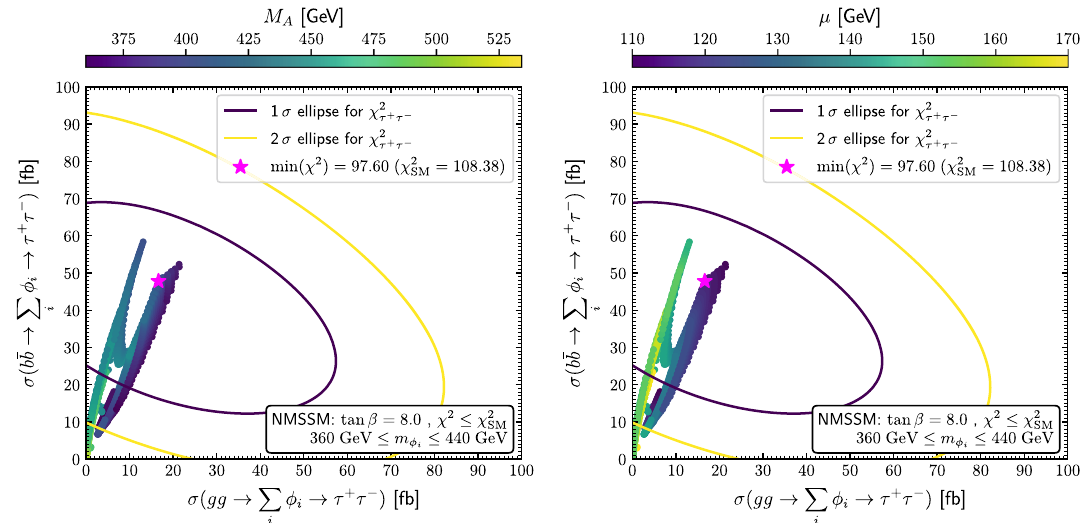
Fig. 18 NMSSM parameter points of the scan with tan β = 8 . 0 (see Table 4): signal cross sections for the τ + τ − excess for the gg produc- tion mode on the horizontal axis and the b ¯ b production mode on the vertical axis. The colors of the points indicate the value of M A (left)